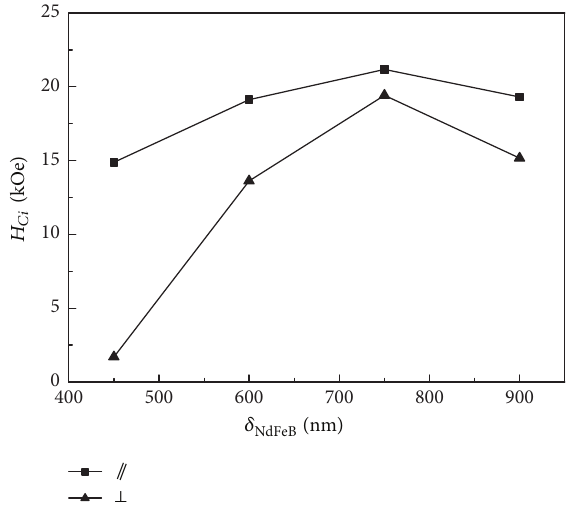
Figure 4: Dependence of the coercivity on the NdFeB layer thick- ness in Ta/Nd/NdFeB/Nd/Ta films.